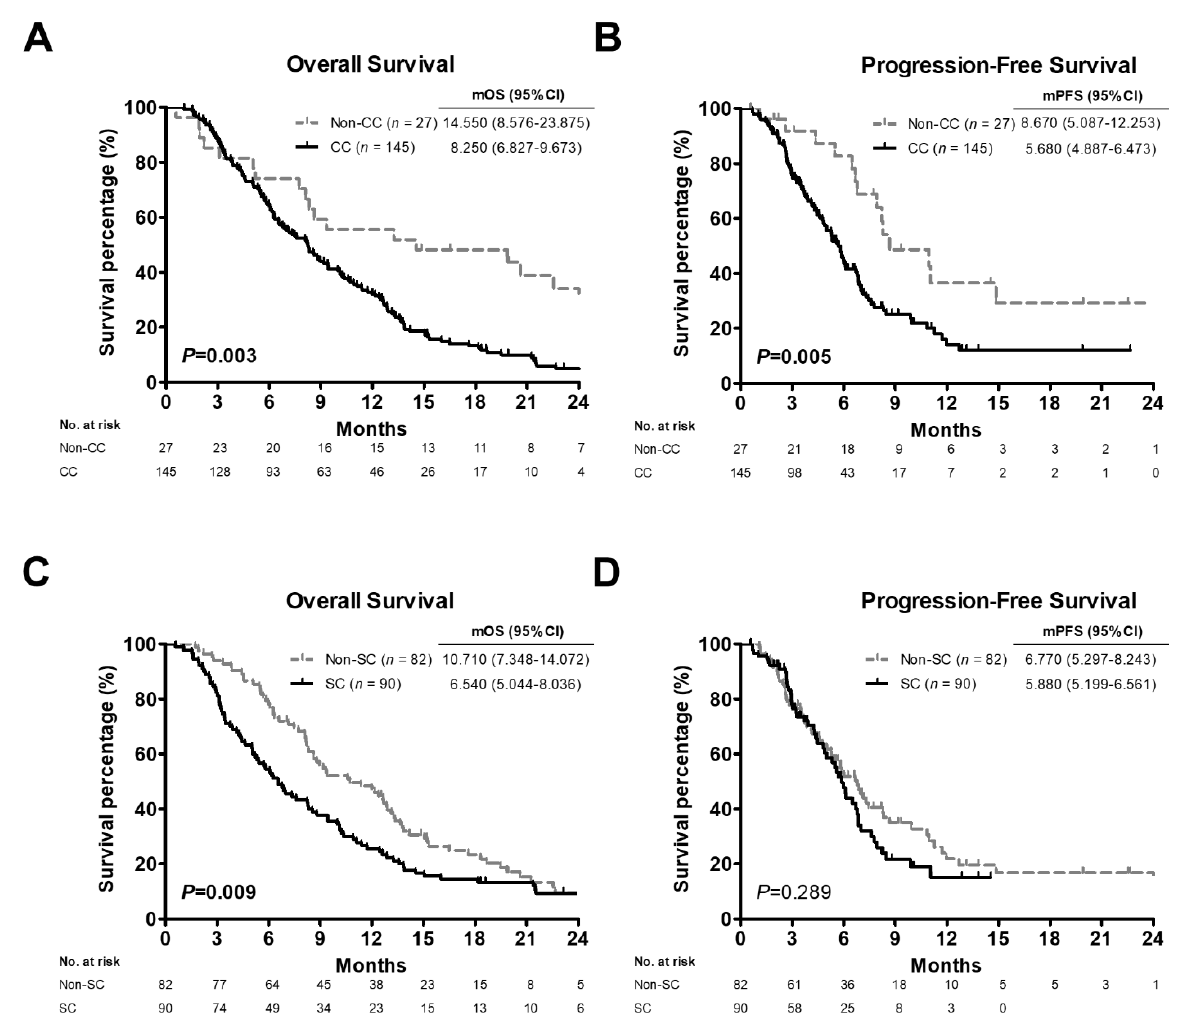
Figure 3. Kaplan-Meier estimate of survival rate in relation to cancer cachexia or sarcopenia status among 172 pancreatic cancer patients receiving chemotherapy treatment. ( A , C ) Overall survival curves of patients with cancer cachexia ( A ) or sarcopenia ( C ). ( B , D ) Progression-free survival curves of patients with cancer cachexia ( B ) or sarcopenia ( D ). p values determined using the log-rank test. CC, positive cancer cachexia status; Non-CC, negative cancer cachexia status; SC, positive sarcopenia status; Non-SC, negative sarcopenia status; mOS, median overall survival; mPFS, median progression-free survival; CI, confidence interval.